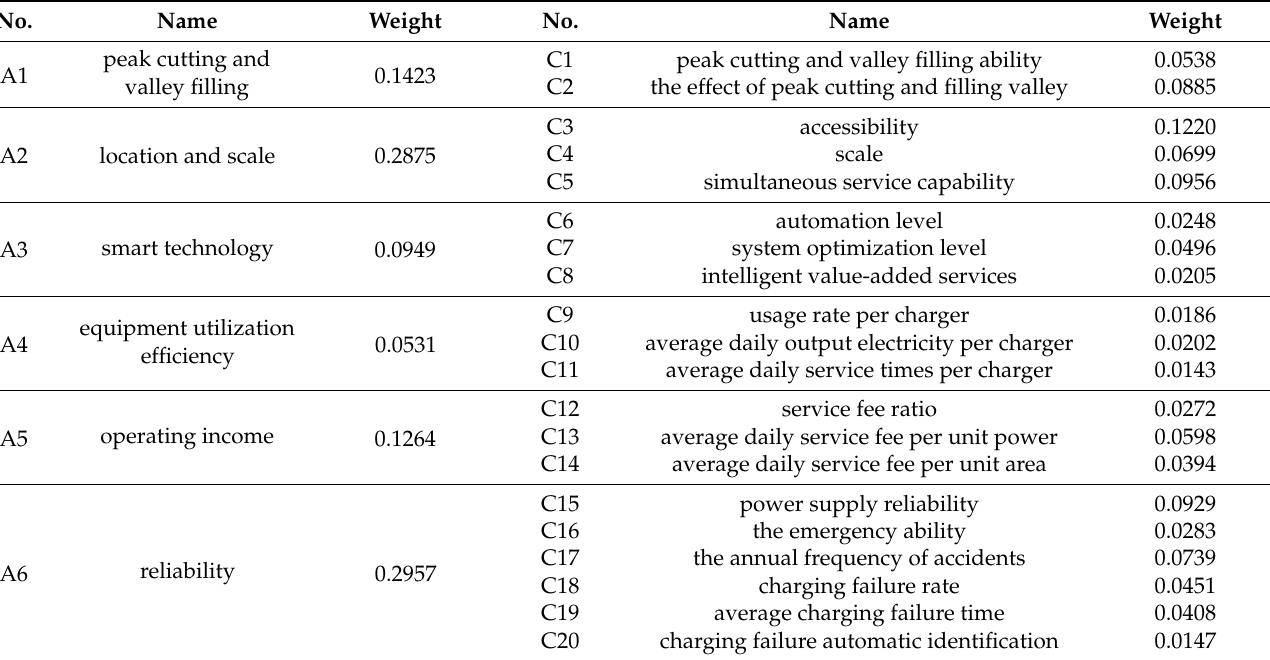
Table 6. Evaluation value of each